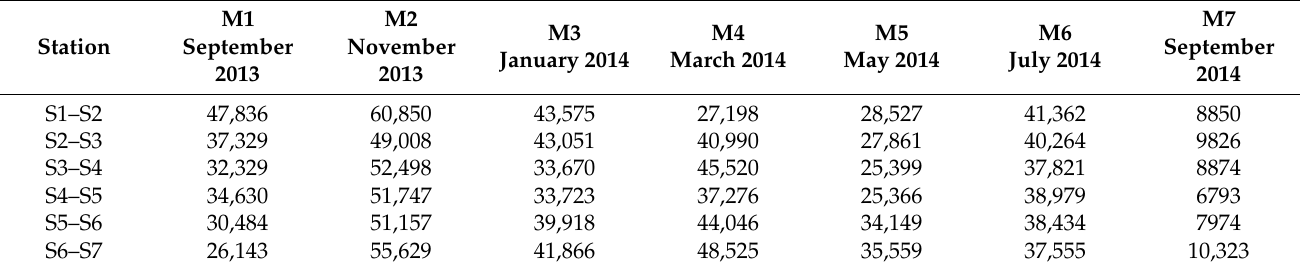
Figure 4. ( a ) Sediment volumes eroded or accumulated between sampling stations, and ( b ) sediment volumes between sampling stations with respect to the initial conditions in September 2013. Table 2. Sediment volumes in m 3 registered among the stations. The volumes were calculated according to V = ( AP 1 + AP 2/2 ) ∗ d , where AP is the area of each beach profile and d is the distance between them (300 m).